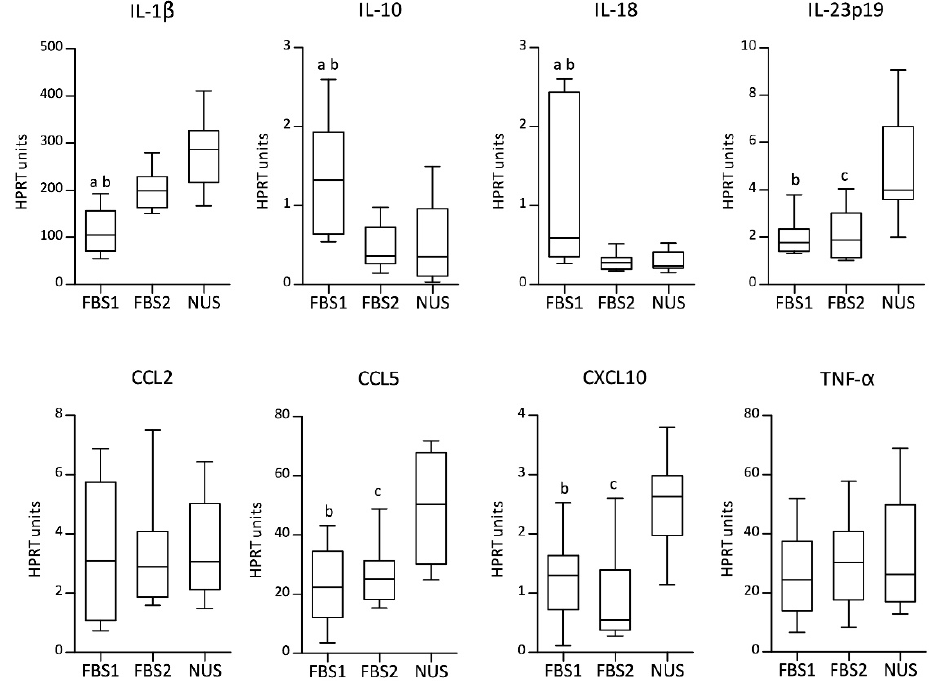
Figure 5. The relative mRNA expression of IL-1 β , IL-10, IL-18, IL-23p19, CCL2, CCL5, CXCL10, and TNF- α assessed by qPCR is presented as HPRT units. Boxplots represent data from the MDM culture with fetal bovine serum (FBS1 and FBS2) or with reduced-serum medium (NUS): median (line), first and third quartiles (box), and minimum and maximum (whiskers); n = 12. Significant differences (Friedman test with Dunn’s multiple-comparison post hoc test) between groups are marked as follows: a FBS1 vs. FBS2, p < 0.05; b FBS1 vs. NUS, p < 0.05; c FBS2 vs. NUS, p < 0.05.